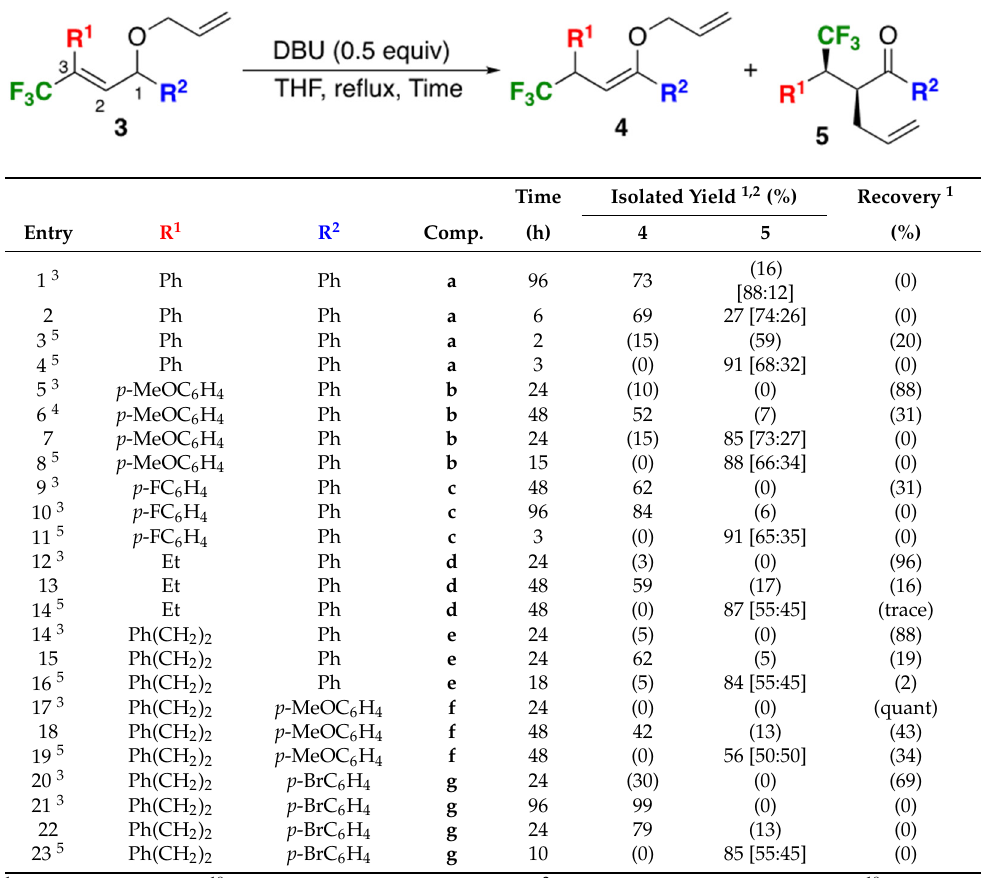
Table 3. Base-mediated isomerization of bisallyl ethers 3 .